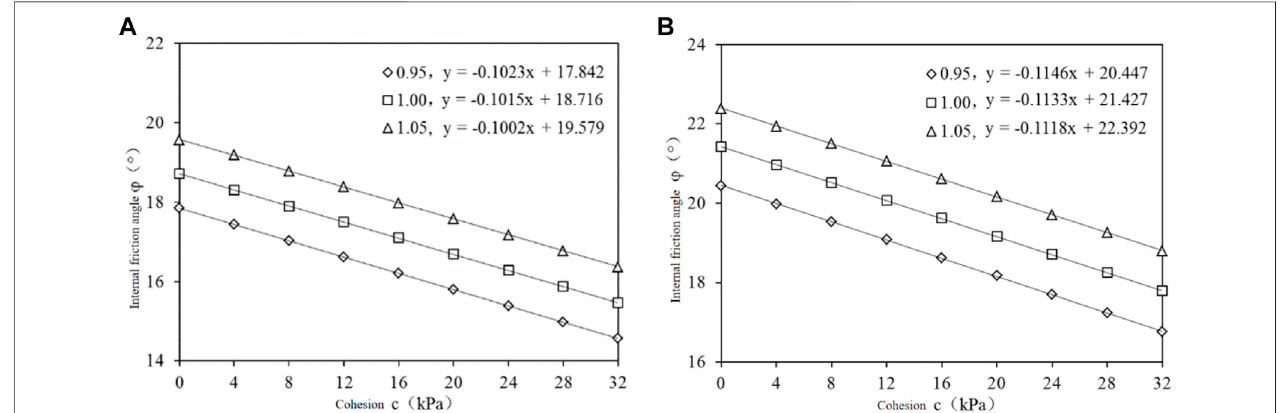
FIGURE 13 | Calculation results of inverse analysis. (A) Natural groundwater-free state. (B) Groundwater in heavy rainfall.